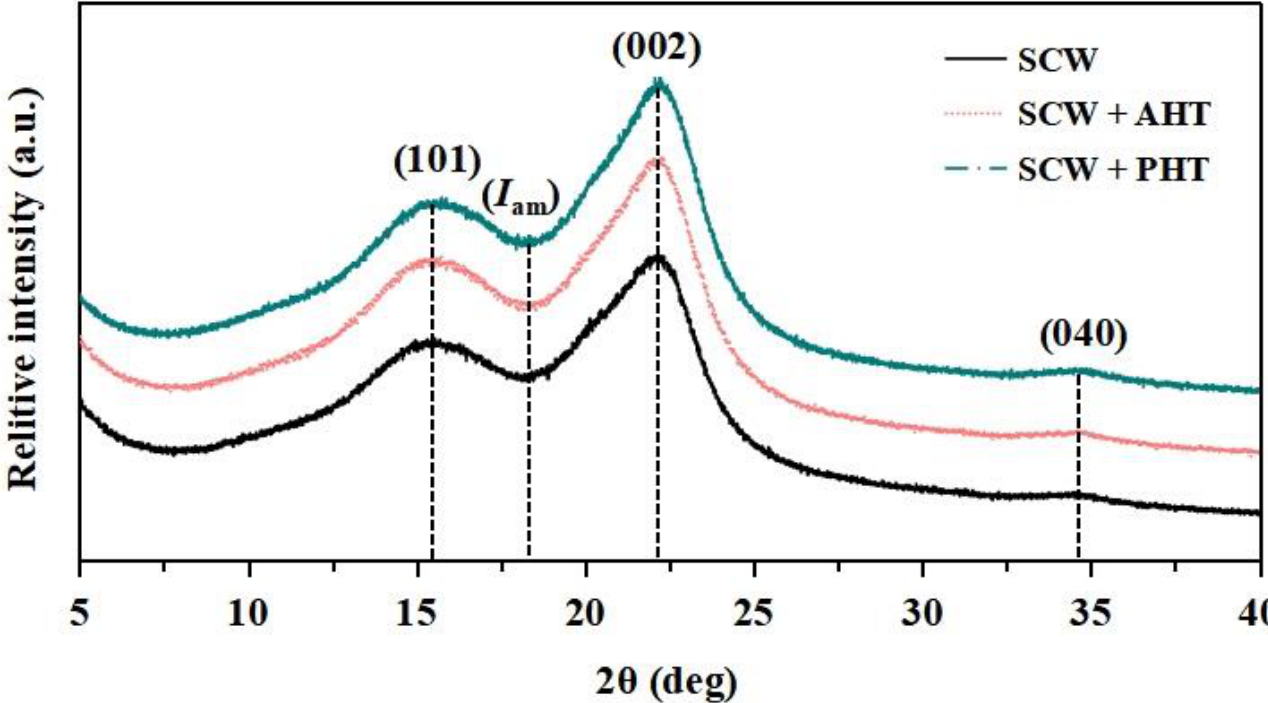
Figure 5. XRD spectrum of SCW, SCW + AHT, and SCW + PHT. SCW, surface-compressed wood without post-treatment; SCW + AHT, surface-compressed wood with atmospheric steam heat treat- ment; SCW + PHT, surface-compressed wood with pressurized steam heat treatment.